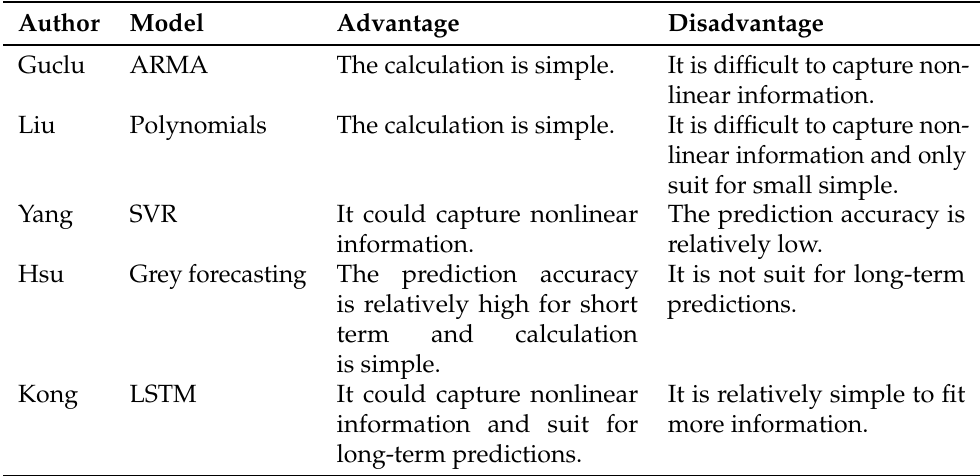
Table 1. Comparison of various prediction